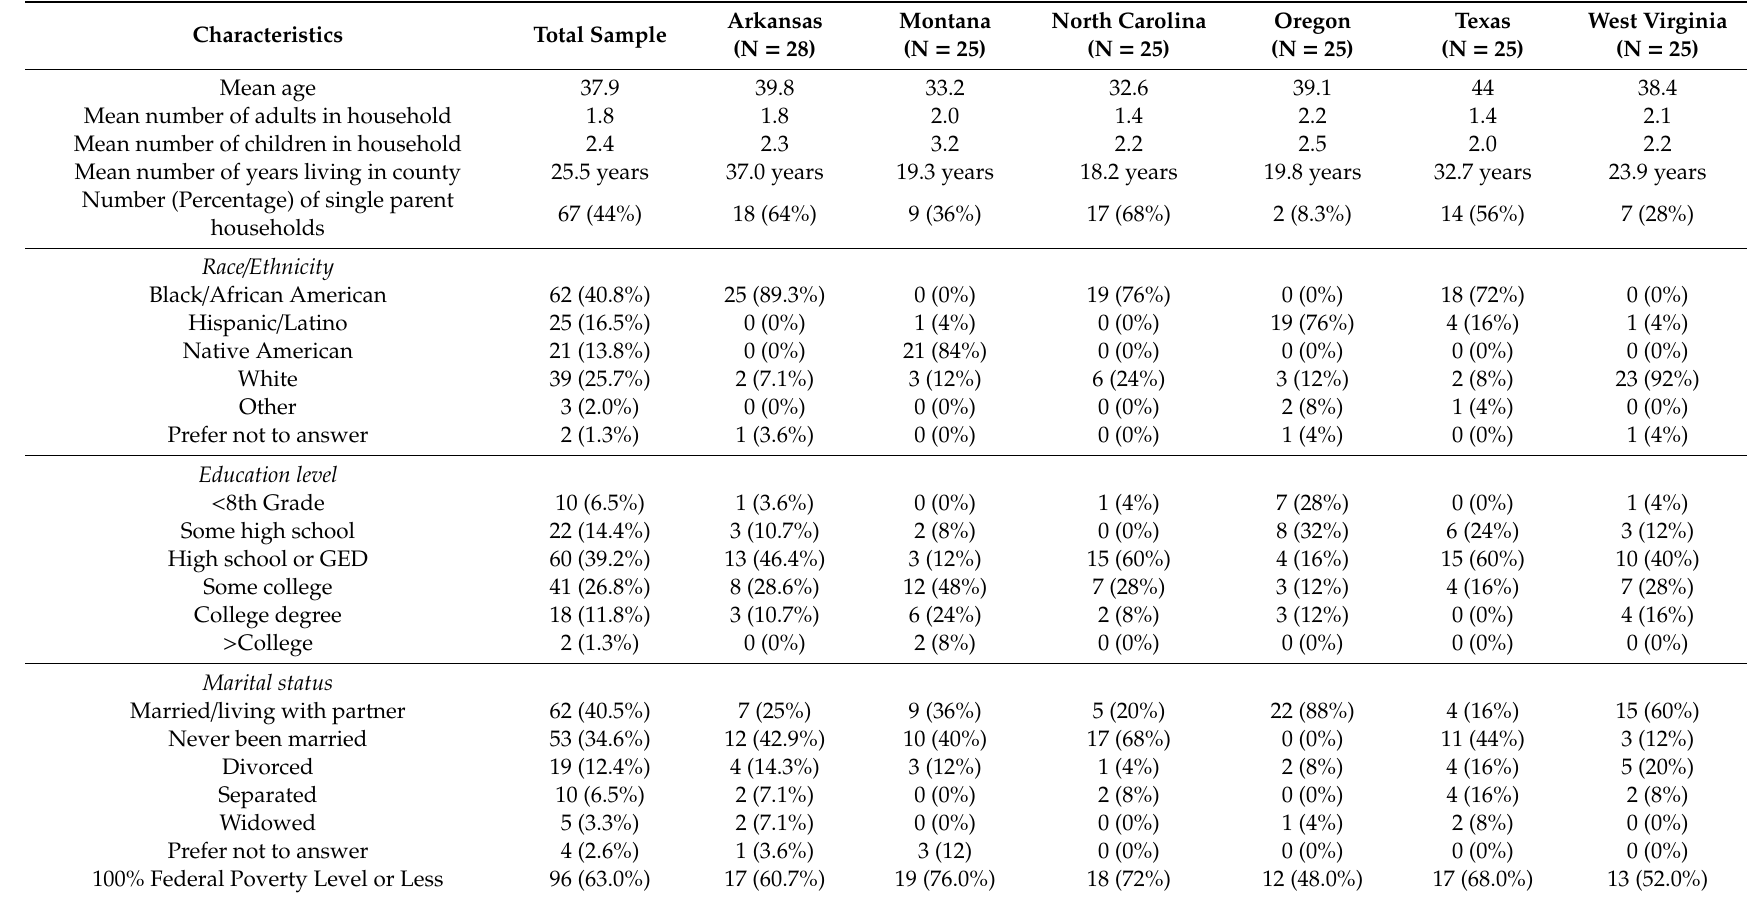
Table 2. Study participant demographics (N =